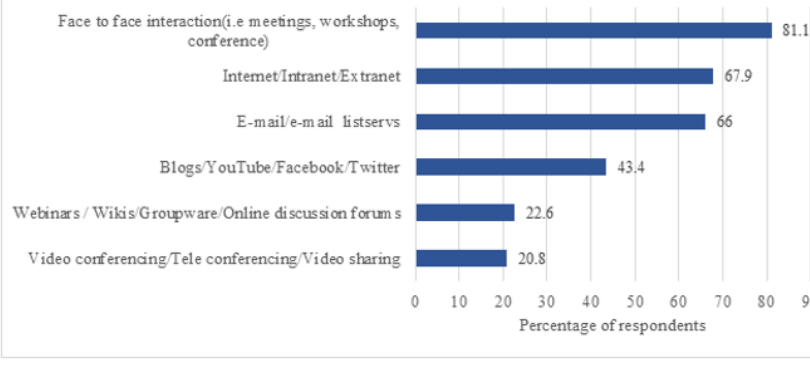
Figure 1 Channels of knowledge sharing among health sciences librarians in Africa